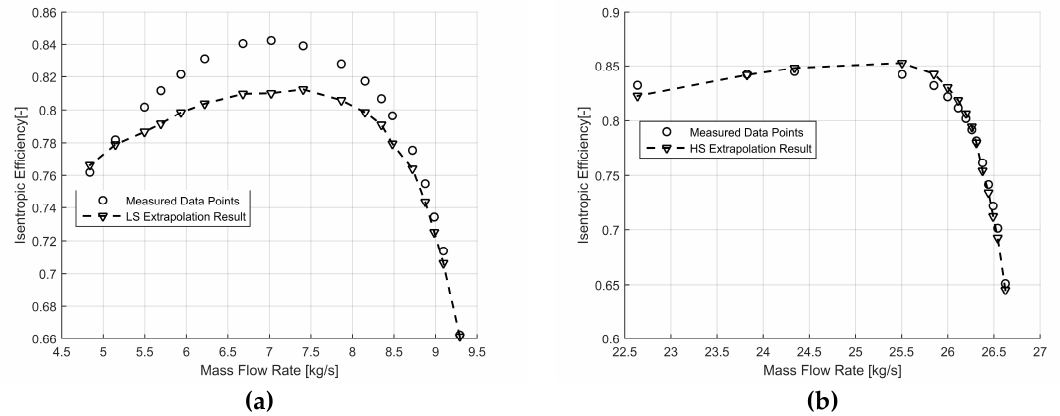
Figure 10. Extrapolation result of the zonal compressor isentropic efficiency model: ( a ) LS (Low Speed) area extrapolation result; ( b ) HS (High Speed) area extrapolation result.